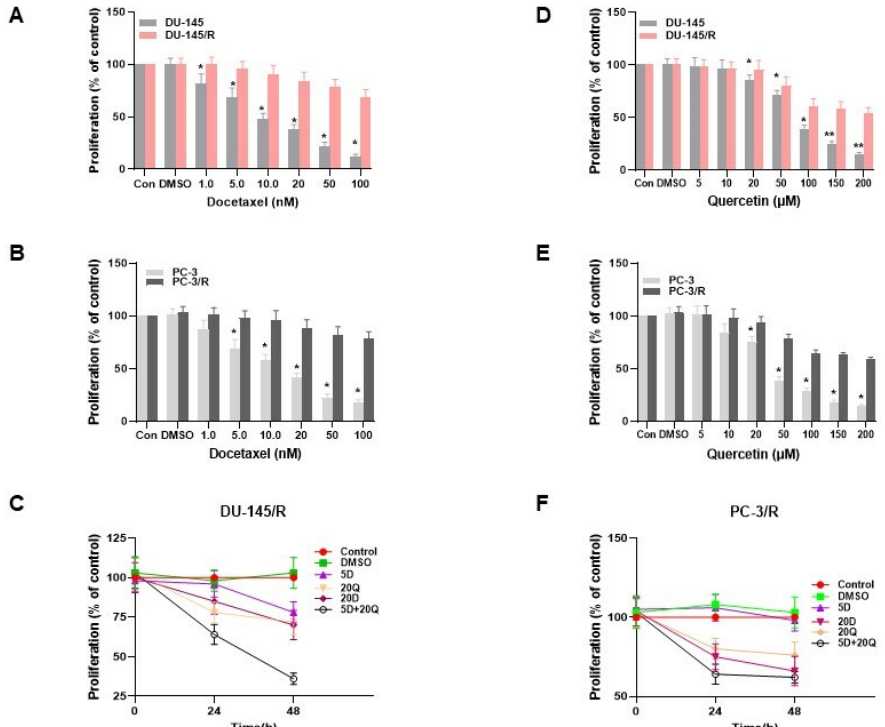
Figure 3. Generation of docetaxel-resistant prostate cancer cell lines and reversal of docetaxel resistance of quercetin using TAP-2 on proliferation. The generated docetaxel-resistant prostate cancer cells and docetaxel-naïve prostate cancer cells were treated with different concentrations of docetaxel or quercetin as indicated. 24 h later, the viability was measured using an assay as described in Section 2. ( A ) DU-145/R or DU-145 treated with docetaxel (nM). ( B ) PC-3– or -PC-3/R treated with docetaxel (nM). ( C ) DU-145/R treated with different concentrations of docetaxel or quercetin or their combination using TAP-2 approach (1.0 nm of docetaxel and 20 µ M of Quercetin) ( D ) DU-145 or DU-145/R treated with quercetin( µ M) ( E ) PC-3 or PC-3/R treated with quercetin ( µ M). PC-3/R ( F ) PC-3/R treated with different concentrations of docetaxel or quercetin or their combination using the TAP-2 approach (1.0 nm of docetaxel and 20 µ M of Quercetin as indicated). Cell viability was determined at 24 h or 48 h. Results are the mean ± SD of three independent experiments performed in triplicate. * p < 0.05, ** p < 0.01, compared with control group of both cell